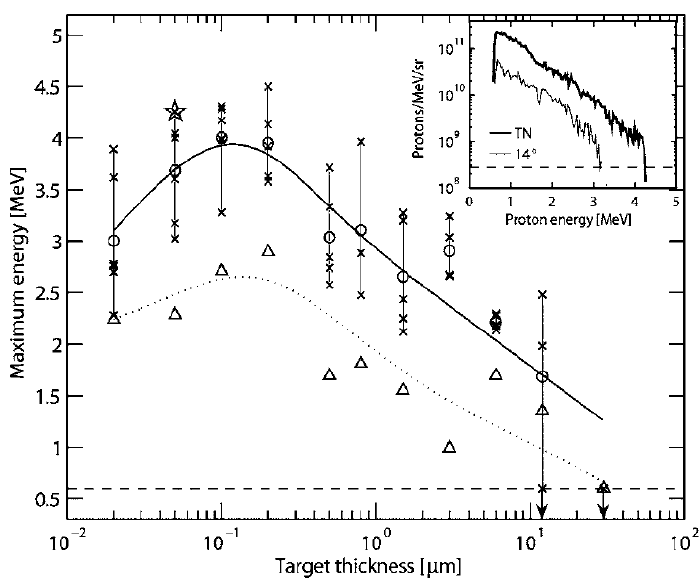
Figure 6. The proton spectra at 0° (target normal) and 14° [35] as a function of aluminum target thickness. The contrast ratio is ~10 10 and laser intensity is ~10 19 W·cm − 2 . The maximum energy increases as the thickness decreases with a maximum near 100 nm. Reproduced from [35]. Copyright 2006, AIP Publishing